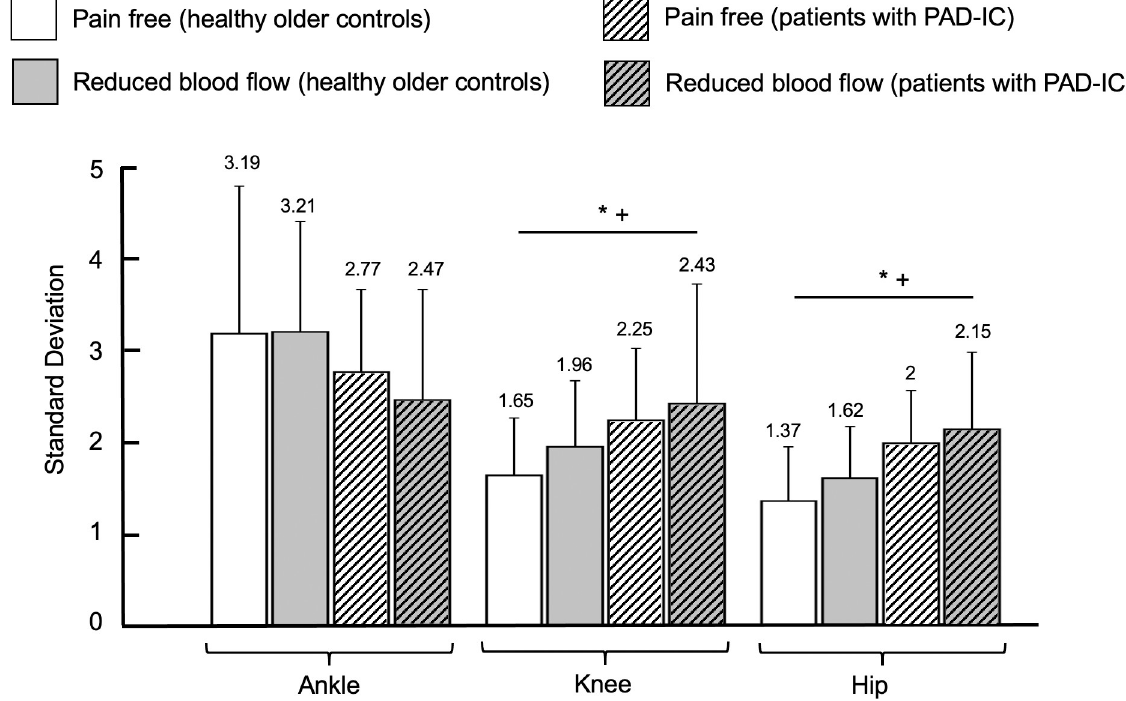
Fig 1. Standard deviation for healthy older controls and for patients with Peripheral Artery Disease with Intermittent Claudication (PAD-IC) in the pain free and reduced blood flow conditions for ankle, knee, and hip ranges of motion. � indicates significant differences between conditions (pain free vs. reduced blood flow, p < 0.05). + indicates significant differences between groups (healthy older controls vs. PAD-IC, p < 0.05). # indicates post-hoc tests where significant interaction exists between groups and conditions. Bar graphs represent the mean values and error bars represent the standard deviation. Mean value for each bar was mentioned at the top of the corresponding error bar.